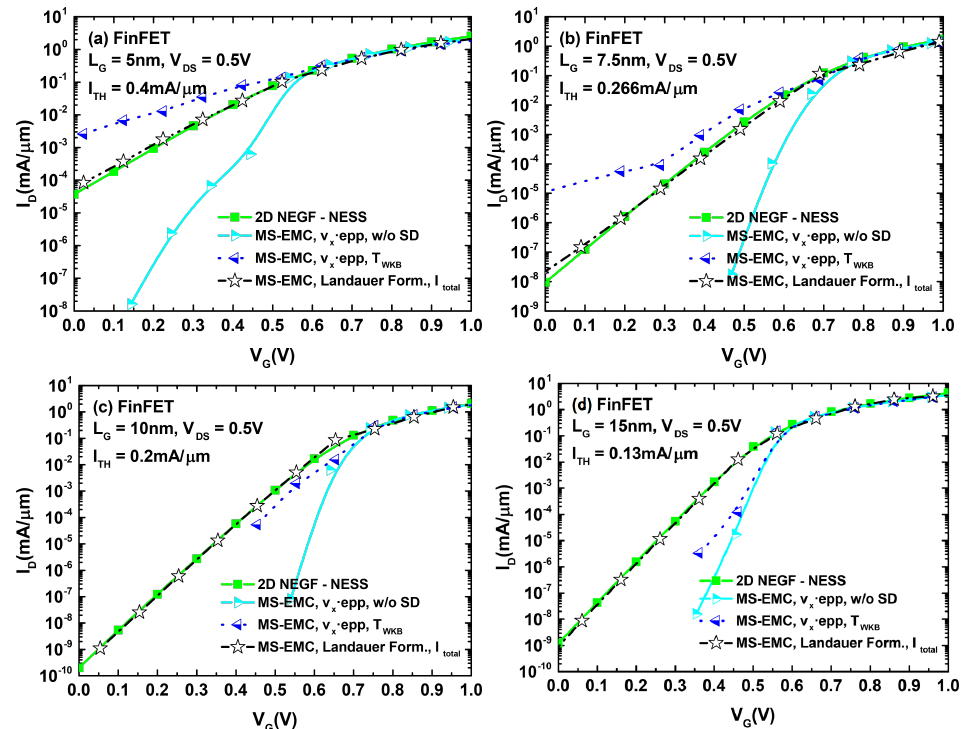
Figure 10. I D − V G characteristics for the FinFET with different gate lengths: ( a ) L G = 5 nm, ( b ) L G = 7.5 nm, ( c ) L G = 10 nm, and ( d ) L G = 15 nm. Analogously to the DGSOI, the displayed current curves correspond to: NEGF, MS-EMC with the standard current computation (with and without S/D tunneling), and MS-EMC using the Landauer